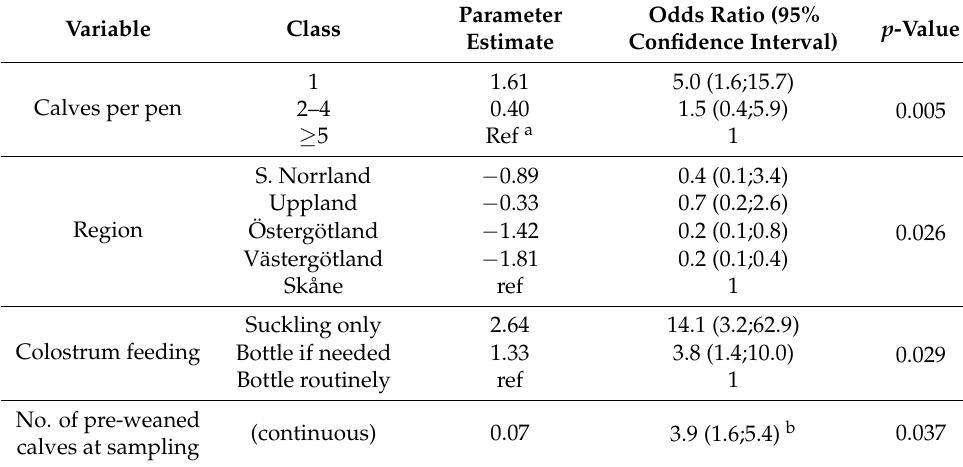
Table 2. Multivariable regression model of factors associated with bovine norovirus shedding detected by RT-PCR in 250 preweaned